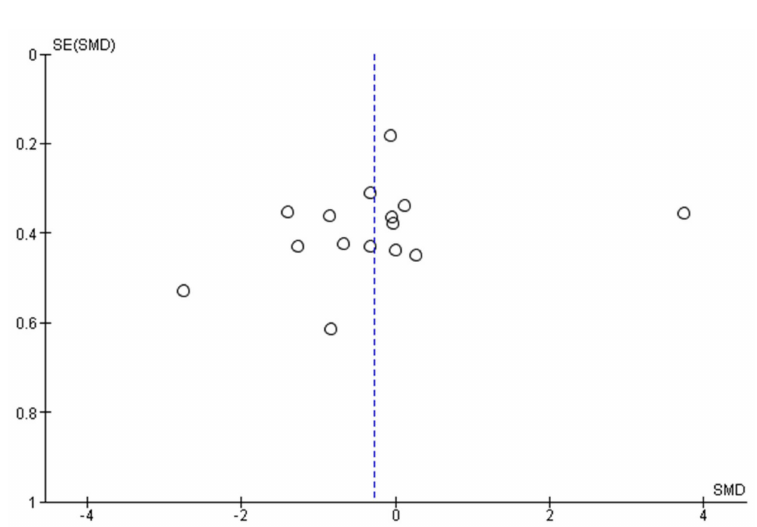
Figure 11. Funnel plot